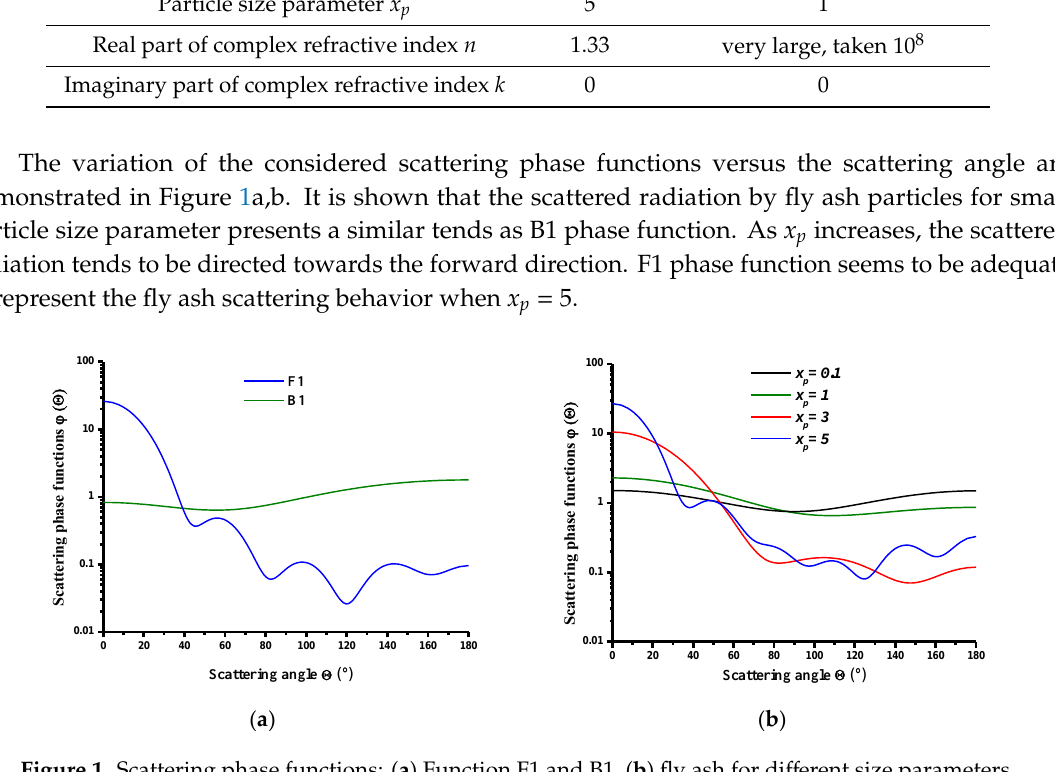
Figure 1. Scattering phase functions: ( a ) Function F1 and B1, ( b ) fly ash for different size parameters. Figure 2a–c presents the net radiation heat flux density in y direction 𝑞 ∗ (cid:3052)(cid:3046) =𝑞 (cid:3052)(cid:3046) /𝐸 at the middle of bottom wall, along the z coordinate. The (FVM + ME) predictions corresponding to the isotropic